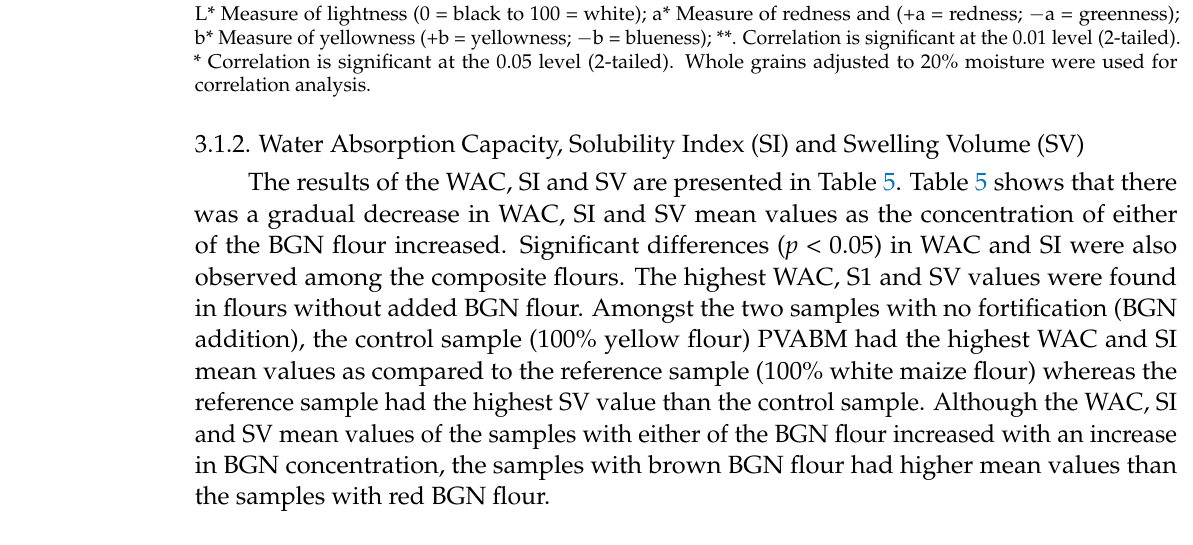
Table 5. The WAC, SI and SV of the BGN-PABM composite flours compared to white maize flour (reference) and PVABM